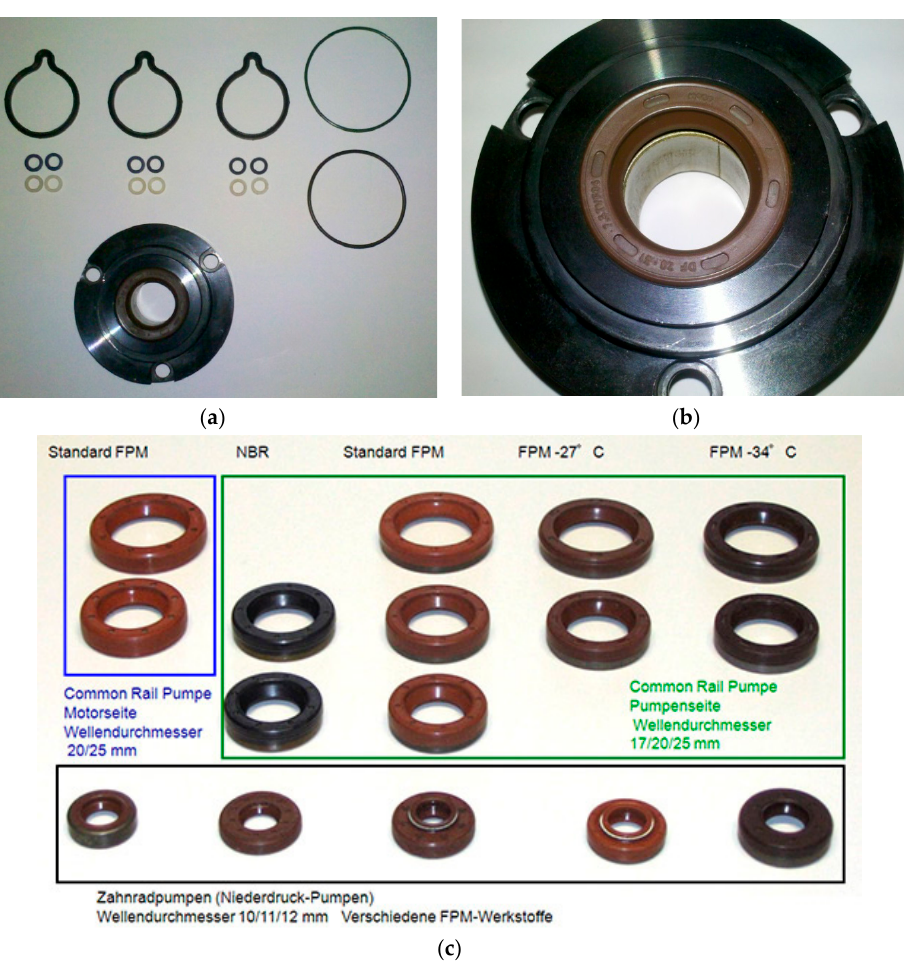
Figure 20. Elastomer parts of CP1S pump (gaskets, O-rings, washers, and seal). (a) pump gaskets and o-rings; (b) pump drive shaft seal; ( c ) materials employed in diesel fuel pump shaft seals [44].